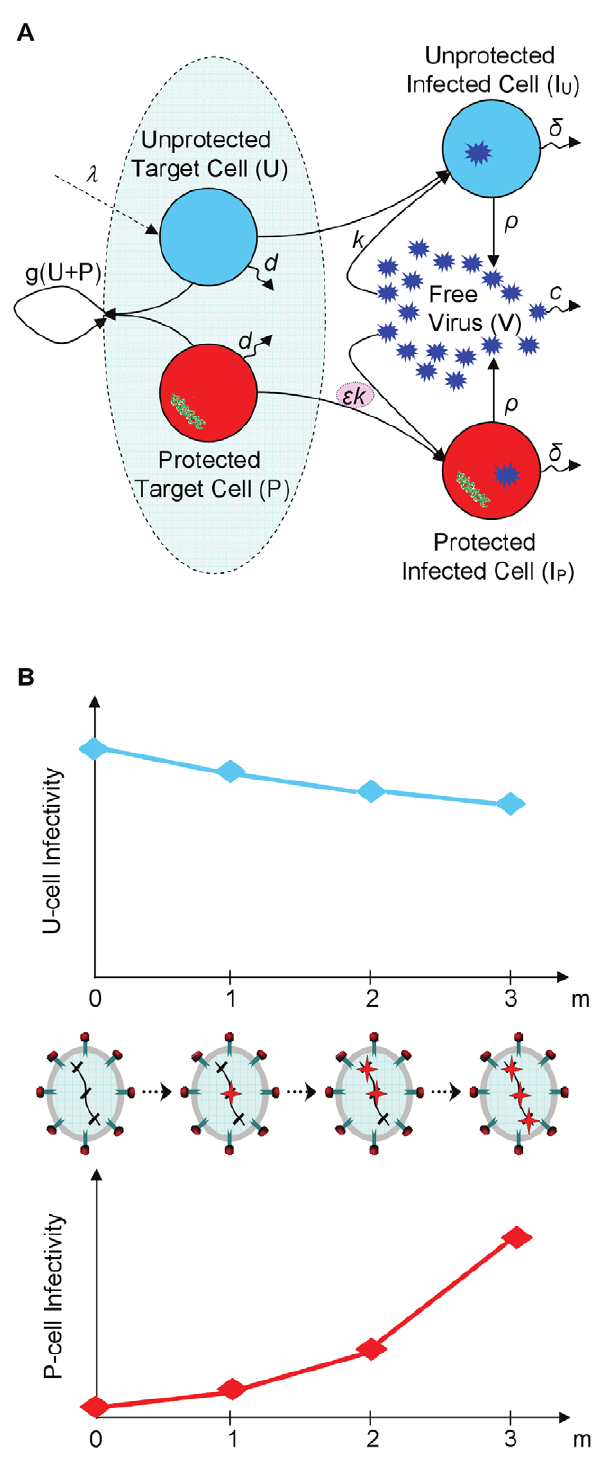
Figure 1. Schematic illustration of infection dynamics under gene therapy and of the development of resistance to it. (A) Diagram of the baseline model, which considers only a single sensitive viral strain. Two types of T cells are considered: gene-modified cells which are protected from infection (shown in red) and non-modified cells that are susceptible to it (shown in blue). The proliferation rate of both cell populations is determined by a saturating function, g ( U z P ) , which takes a Michaelis-Menten form. Therapy effects are conveyed via an infectivity inhibition factor ( e ) for gene-modified cells. (B) An